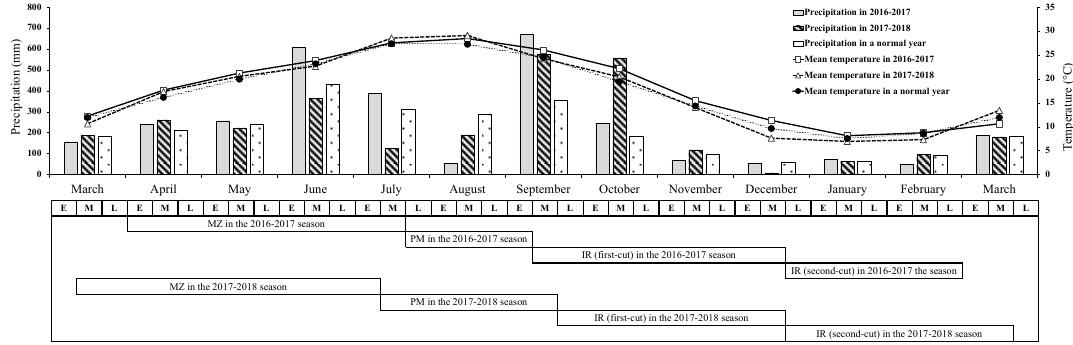
Figure 1. Cultivation schedule and monthly precipitation and mean temperature in the 2016 and 2017 seasons and in a normal year (based on averages for 1980–2010). Source: Japan Meteorological Agency. MZ: spring maize, PM: pearl millet, IR: Italian ryegrass, E: early, M: mid, L: Late.